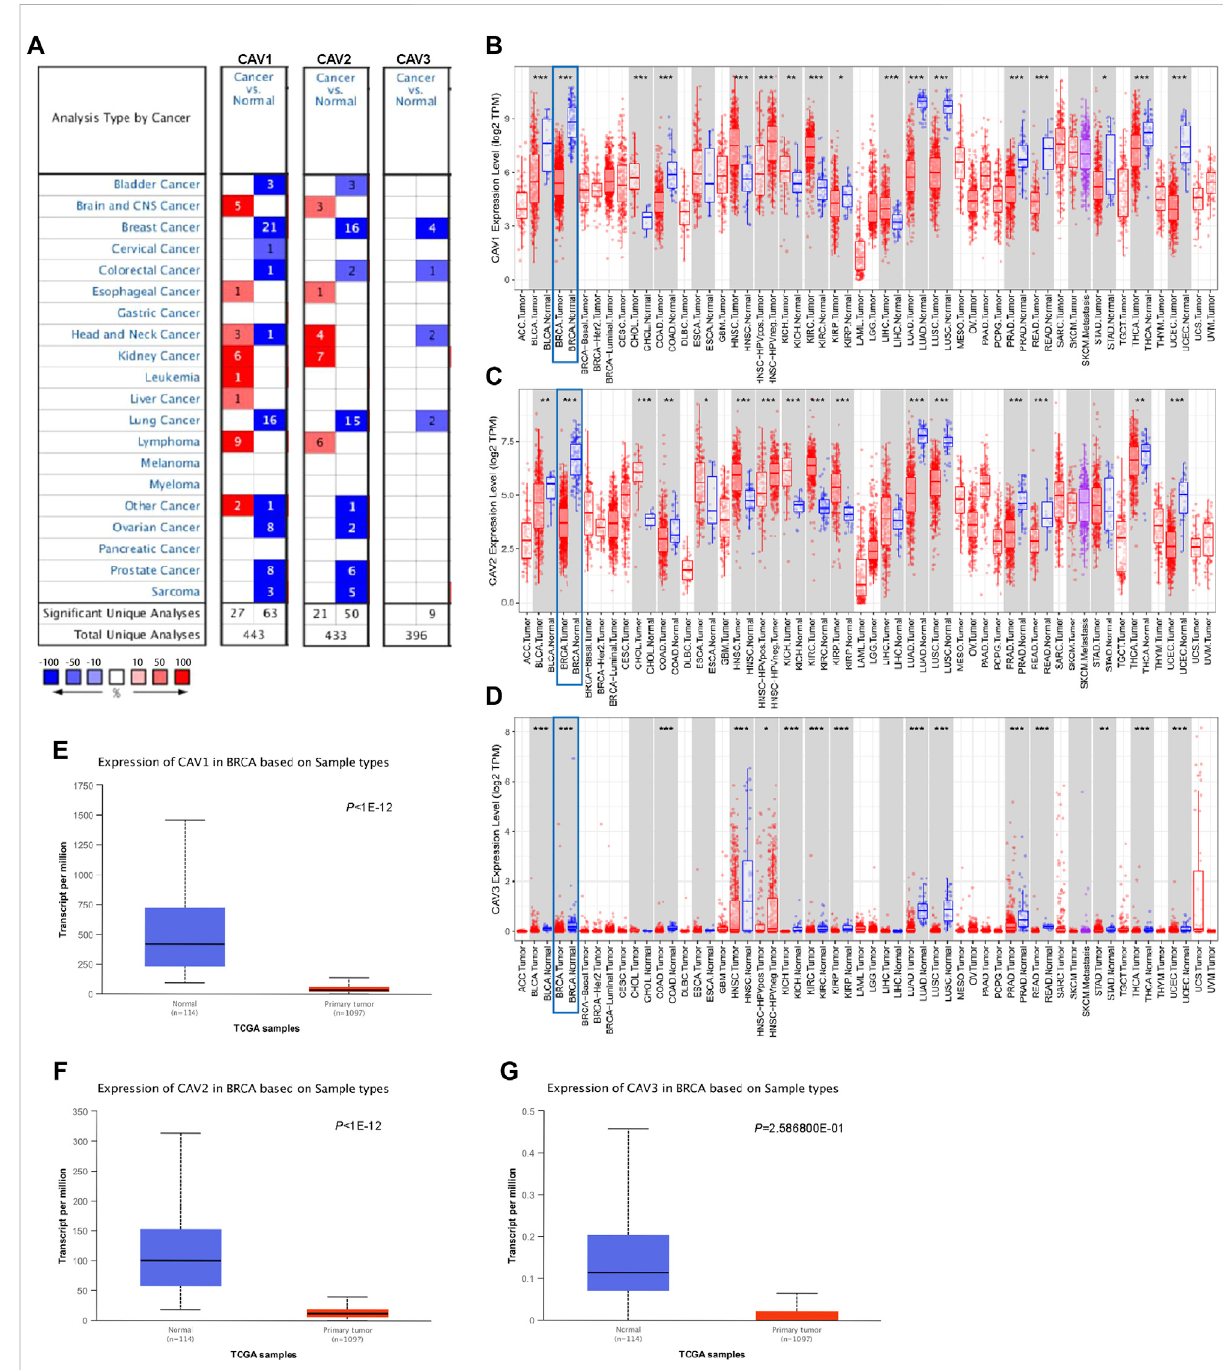
FIGURE 1 Expression of CAV family members in tumors. (A) Transcription levels of CAVs in different human tumor types (Oncomine database, http:// oncomine.org). (B – D) Decreased expression of CAVs in 33 tumor types. Red, tumor samples; gray, normal samples (TIMER database, http://timer. comp-genomics.org/). (E – G) CAVs were expressed low in BC tissues compared with normal tissues (UALCAN database, http://ualcan.path.uab.